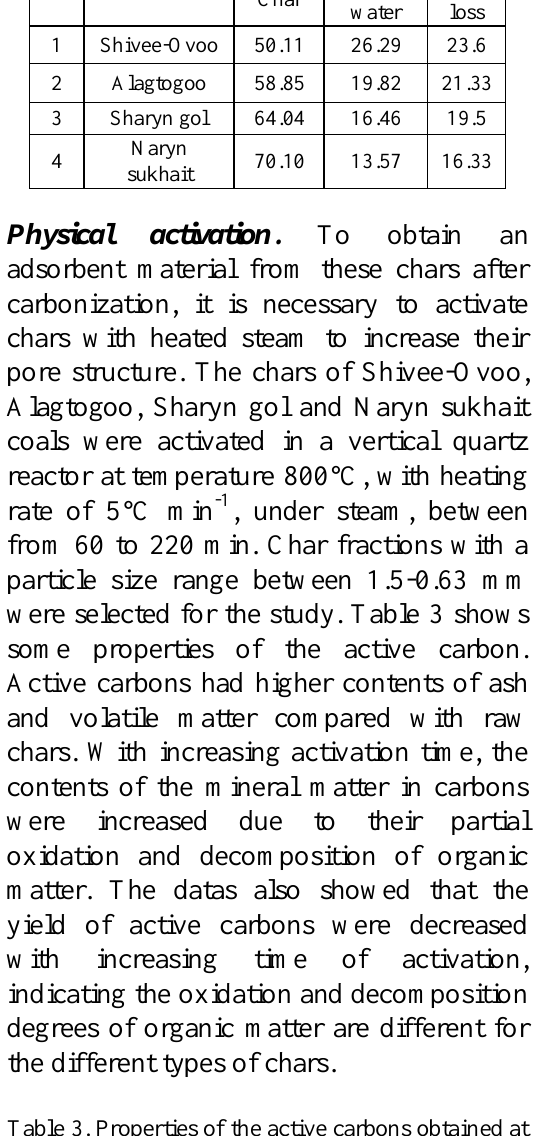
Table 2. Yield of the carbonization products №